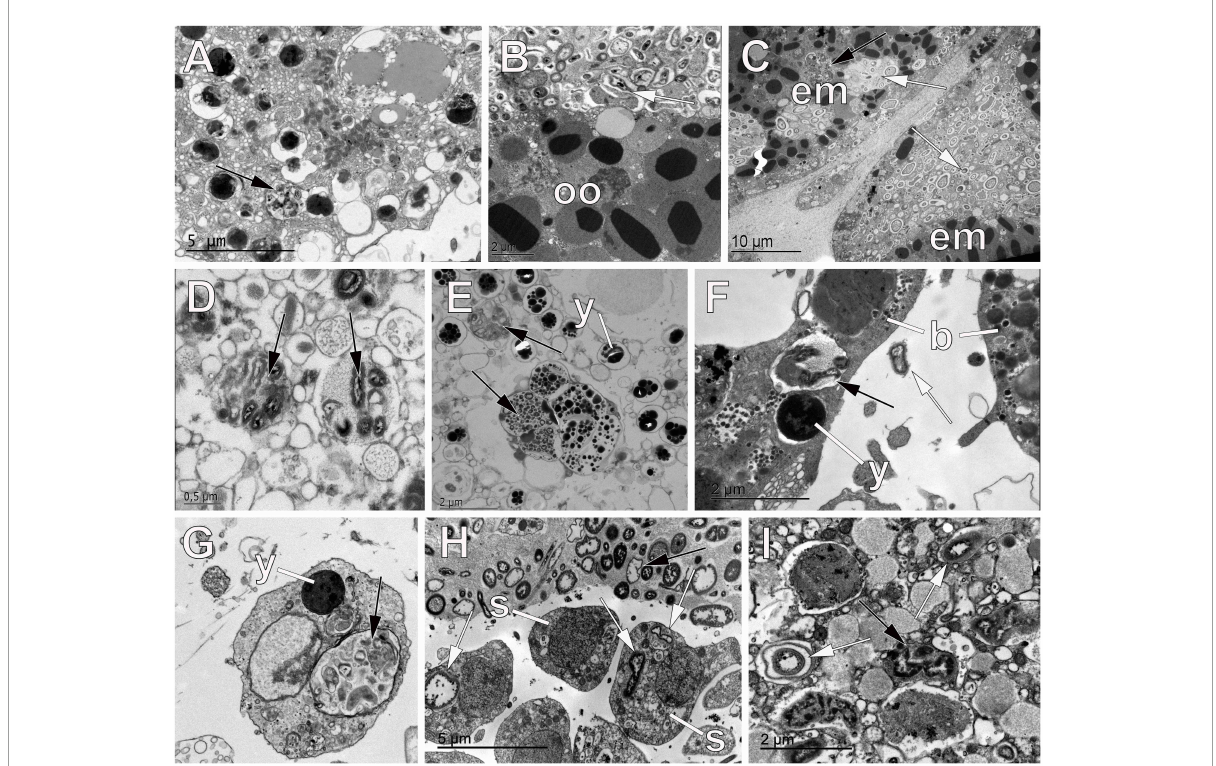
FIGURE5 Digestion of symbiont bacteria within oocytes, sperm, and embryos of sponges. (A) Oocyte of the haplosclerid sponge Hemigellius pilosus showing vesicles of digested bacteria (black arrow) that result into yolk production. (B) Oocyte (oo) of the homosclerophorid Corticium candelabrum showing digestion of bacterial cells (white arrows). (C) Embryos (em) of the homosclerophorid C. candelabrum undergoing the first cleavage division where the accumulated symbionts are dragged into the inside of the developing embryo (white arrows). Note the digestion of some of the bacterial pockets (black arrow). (D,E) Digestion of bacterial symbionts (black arrows) within vesicles of the oolemma of the agelasid Cymbaxinella damicornis . Note the formation of yolk (y) with the products of bacterial digestion. (F) Digestion of symbiont bacteria (black arrow) within blastomeres (b) of the embryo of the poecilosclerid Phorbas areolatus to make yolk (y). Note the similar appearance of symbiotic bacteria (white arrow) occurring between blastomeres. (G) Spermatogonium of the haplosclerid Petrosia ficiformis showing a vesicle with digested bacterial cells (black arrow) and yolk (y) platelets. (H) Spermatic cyst in the tetractinellid sponge Geodia hentscheli showing spermatogonia (s) with bacterial cells (white arrows) within the cytoplasm. Note the similar appearance of the symbiont cells within the mesohyl (black arrow) and the lack of follicle that allows bacteria to enter the lumen of the cyst. (I) Oocyte of the tetractinellid sponge G. hentscheli showing digestion of bacterial cells (black arrows) and intact symbionts (white arrows) within vesicles.